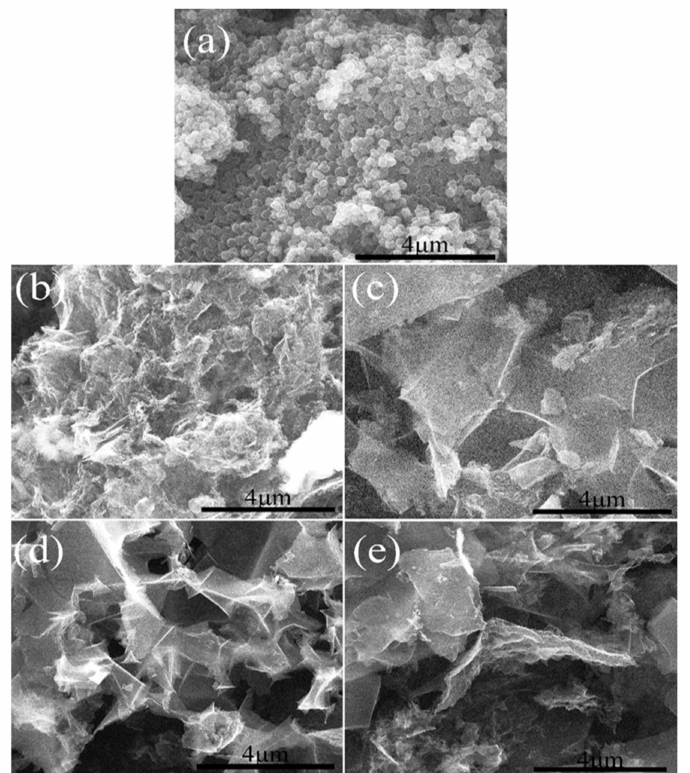
Figure 7. Morphology of one-step activation method materials: ( a ) CAPN; ( b ) APCNs-0.5;